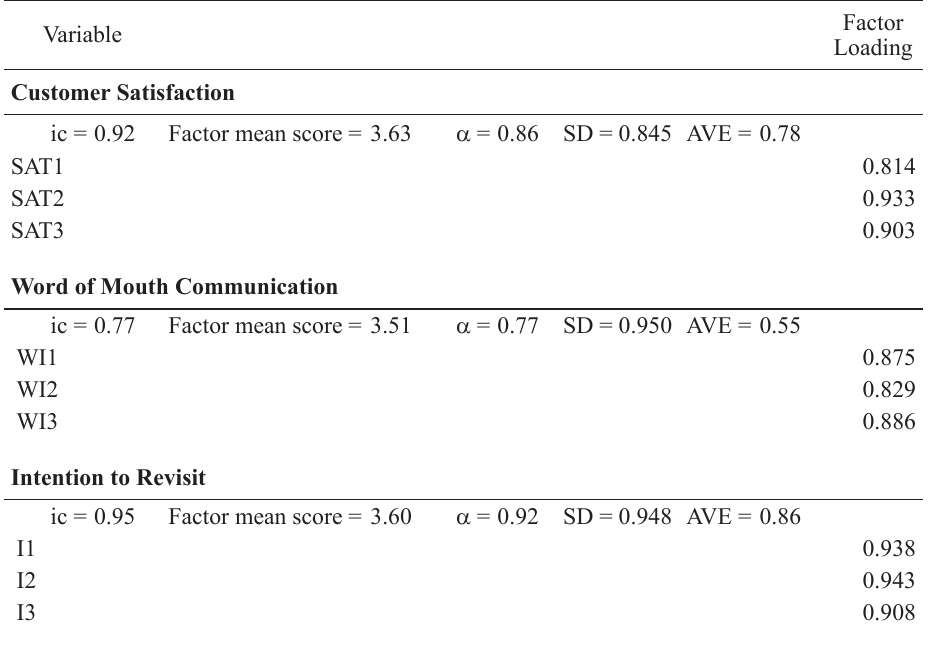
Table 1. Convergent and discriminant validity of the model